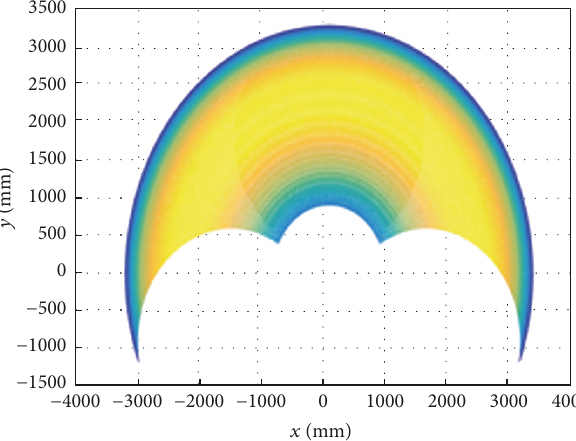
Figure 11: Transmission performance of the robot in 𝑥 - 𝑦 plane.